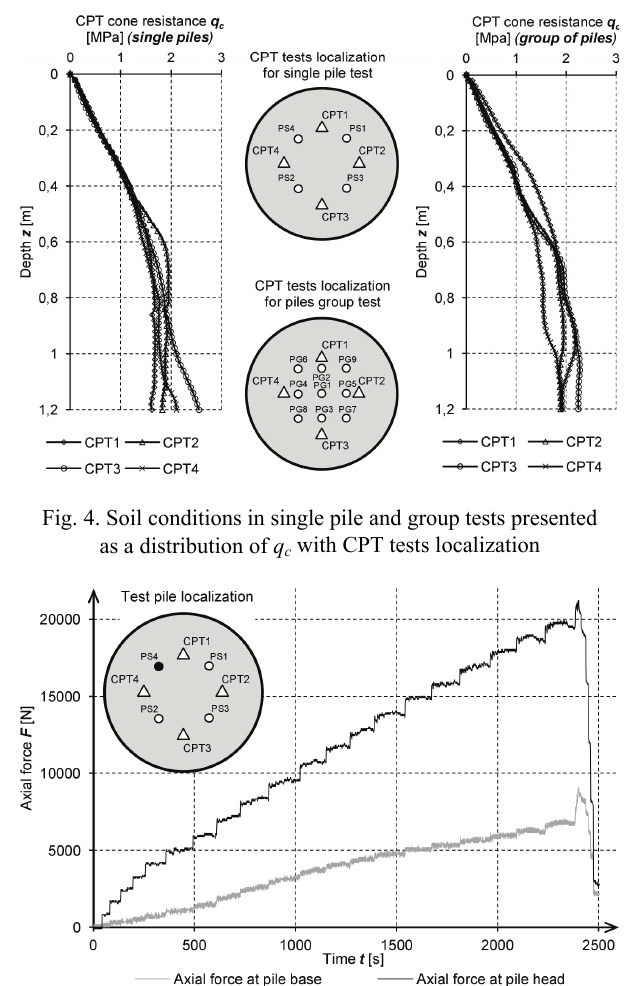
Fig. 5. Axial force changes during the load test of single SDP pile no. PS4